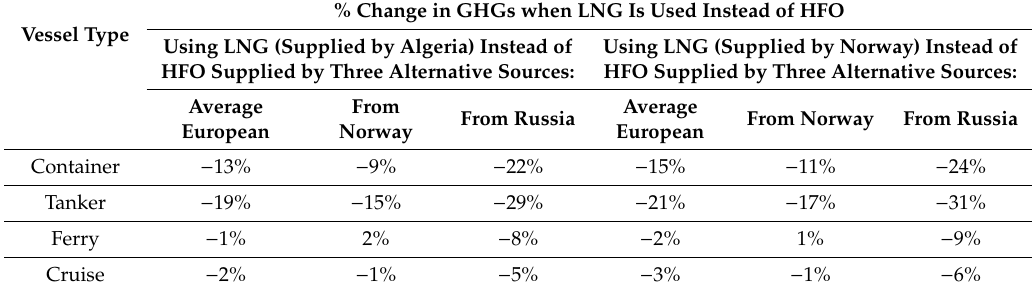
Table 7. Trends for Well-to-Propeller GHG for di ff erent case setups using di ff erent fuel supply chains of HFO normalized by the two LNG case setup